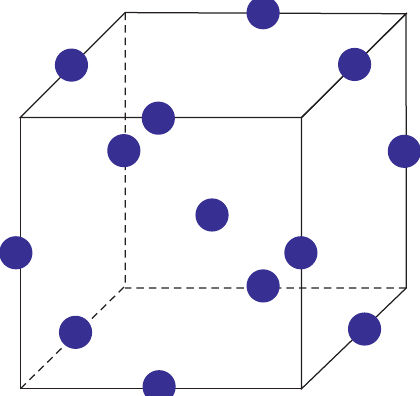
Figure 9: Test point distribution of three-factor BBD experimental design.